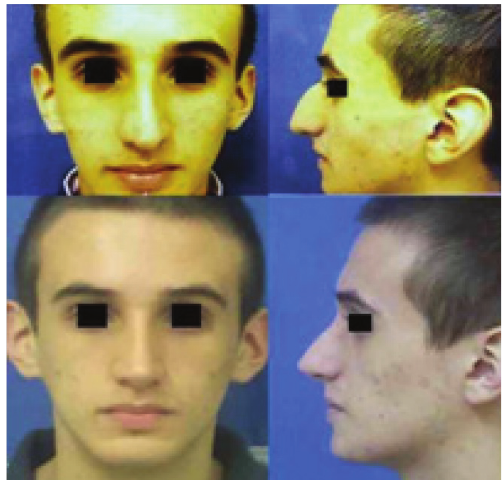
Figure 1 Upper , preoperative anterior and left lateral views ; lower, postoperative anterior and left lateral